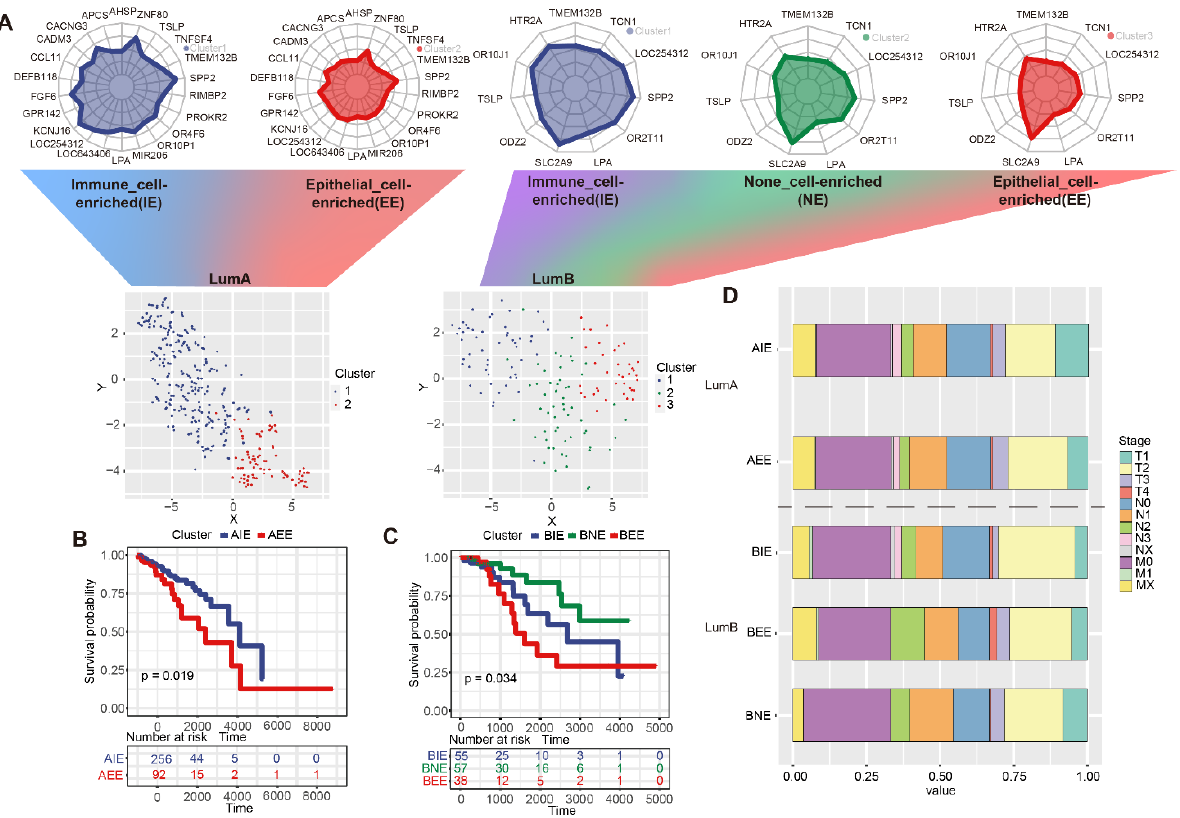
Figure 3. The definition of subgroups in luminal A/B. ( A ) Subgroups of luminal A/B. ( B ) Survival difference of two subgroups in luminal A. ( C ) Survival difference of three subgroups in luminal B. ( D ) Comparison of clinical stages between subgroups in luminal